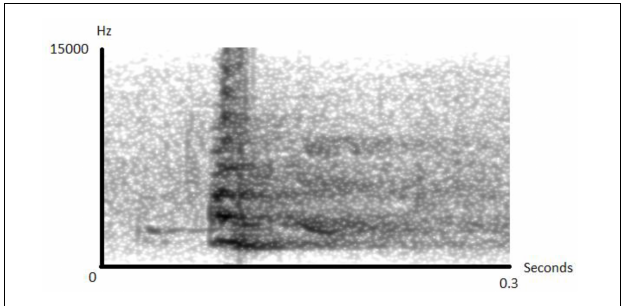
FIGURE 1 | Spectrogram of a snake alarm call given by a female sooty mangabey. When encountering snakes, individuals produce sequences of up to a dozen of such (Spectrogram made in